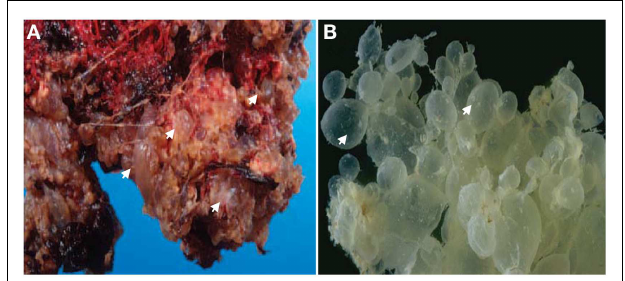
FIGURE 1 | Gross-morphology of HMs . (A) A photograph of gross-morphology of a HM directly after surgical evacuation. Note the presence of vesicles (only four are indicated by arrows) which represent edematic chorionic villi (CV) that have accumulated fluid and are covered with blood. (B) Another gross-morphology photograph of a HM after removing the blood. Note the hydropic degeneration of the CV and their appearance as a grape-like structure (only two are indicated by arrows). In (B) photo courtesy of Professor Edward C. Klatt, School of Medicine, Mercer